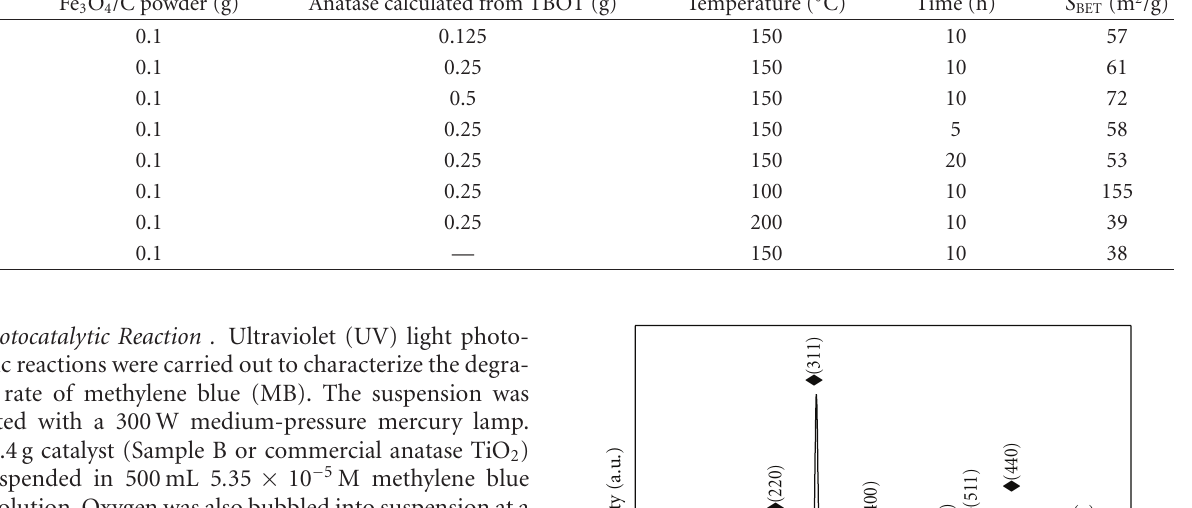
planes of anatase TiO 2 (JCPDS No. 21-1272), respectively. The crystallite size of anatase TiO 2 caculated by Scherrer formula is to be ca. 11.2 nm. And the intensity of XRD peaks of Fe 3 O 4 has been decreased because there is some carbon and anatase TiO 2 coated on it. XRD results demonstrate that the crystalline anatase TiO 2 and Fe 3 O 4 coexist in Sample B.